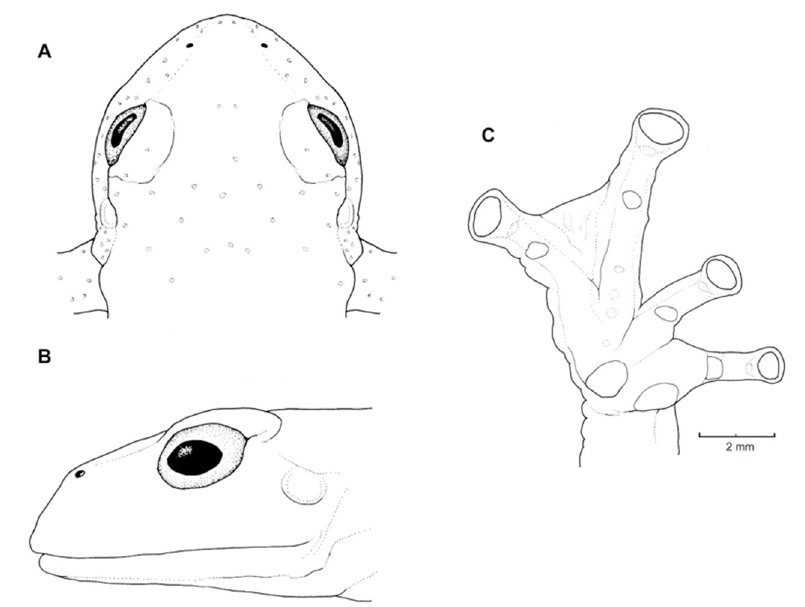
Figure 78. Cochranella resplendens , holotype KU 118053. ( A ) Head in dorsal view. ( B ) Head in lateral view. ( C ) Hand in ventral view. Drawings of head not to scale. Illustrations by Juan M. Guayasamin. Color in life (Figures 77 and 79): Dorsum green with numerous, small white to bluish–white spots. Ventral surfaces mostly white, except posterior portion, which is translucent. Upper lip, tubercles on forearm and foot, and cloacal warts white. Bones green. Iris whitish cream to beige, with fine grey to brown reticulation; pale yellow circumpapilar ring ([22,164], this work). Color in ethanol (Figure 81): Dorsal surfaces of head, body, and limbs slate grey to lavender with small white spots, often corresponding to small, flat tubercles. Upper lip white; tympanum pigmented as surrounding skin. White tubercles present on Fingers III and IV and Toes II–V.